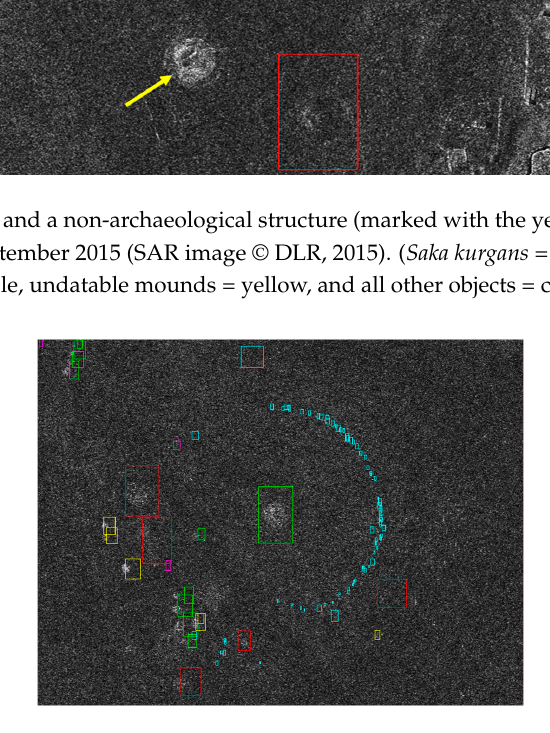
Figure 5. Cluster of Saka kurgans , Scythian kurgans and ogradkas in the TSX ST image from 16 September 2015 (SAR image © DLR, 2015). ( Saka kurgans = red, Scythian kurgans = green, ogradkas = purple, undatable mounds = yellow, and all other objects = cyan).